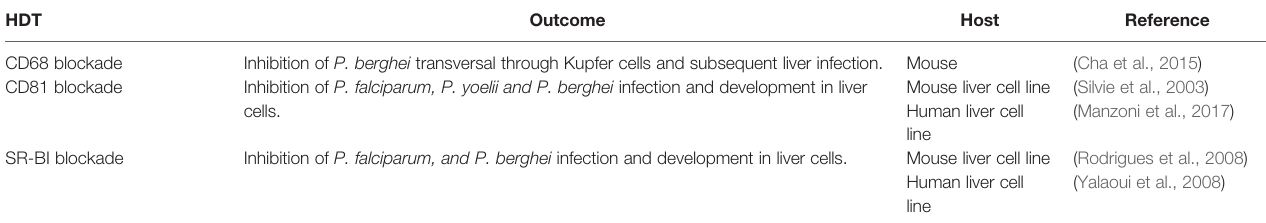
TABLE 2 | Host-directed therapies for